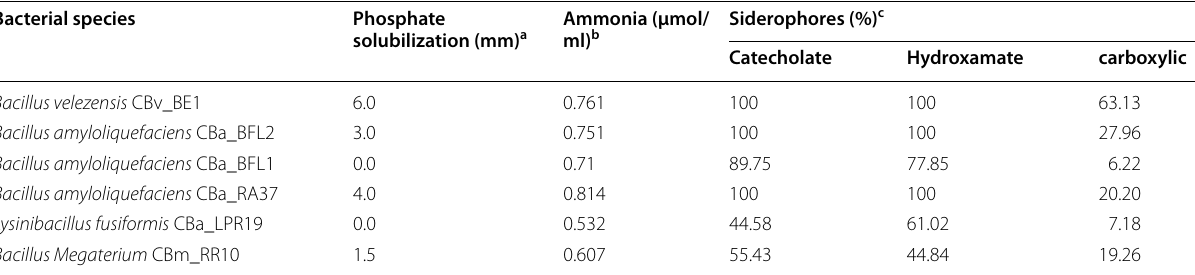
a Mean diameter of clear halo around the bacterium colony b Relative ammonia production in water peptone medium c Percent production of each siderophore type relative to the control treatment